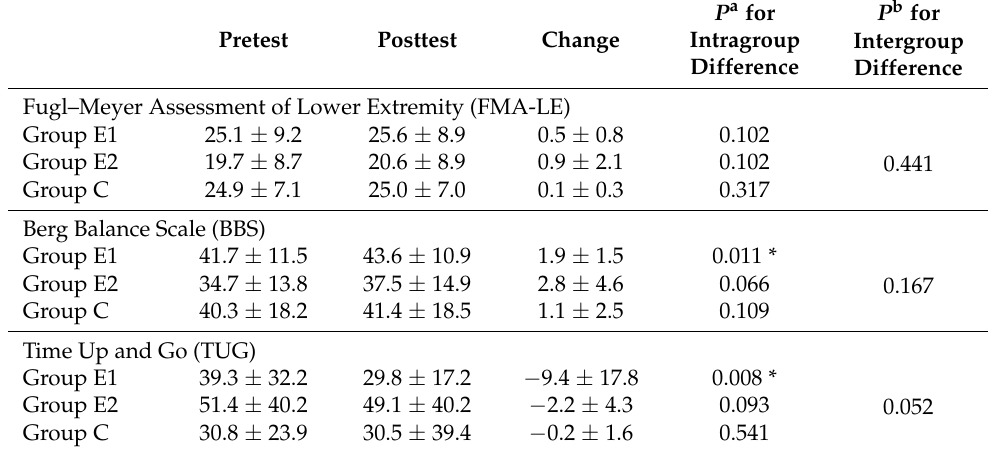
Table 2. Motor performance and functional